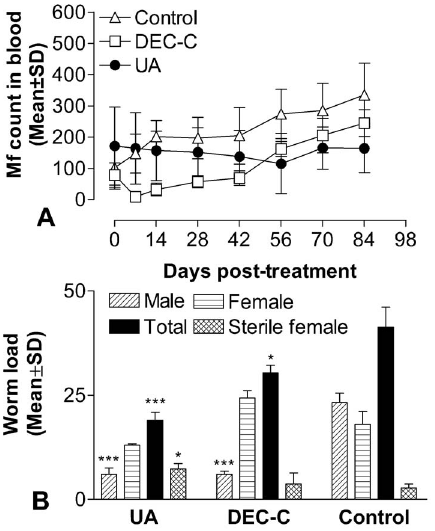
Figure 5. Micro-(A) and macrofilaricidal (B) activity of UA and reference drug diethylcarbamazine-citrate (DEC-C) against Brugia malayi in Mastomyscoucha . Values are mean 6 S.D. of 5 animals from two experiments. (A) No alteration in Microfilarial count in treated animals at each time point post initiation of treatment over day 0. Statistics: Student’s ‘t’ test. Significance level (B) *P , 0.05 (vs sterilized female worm of control animals).